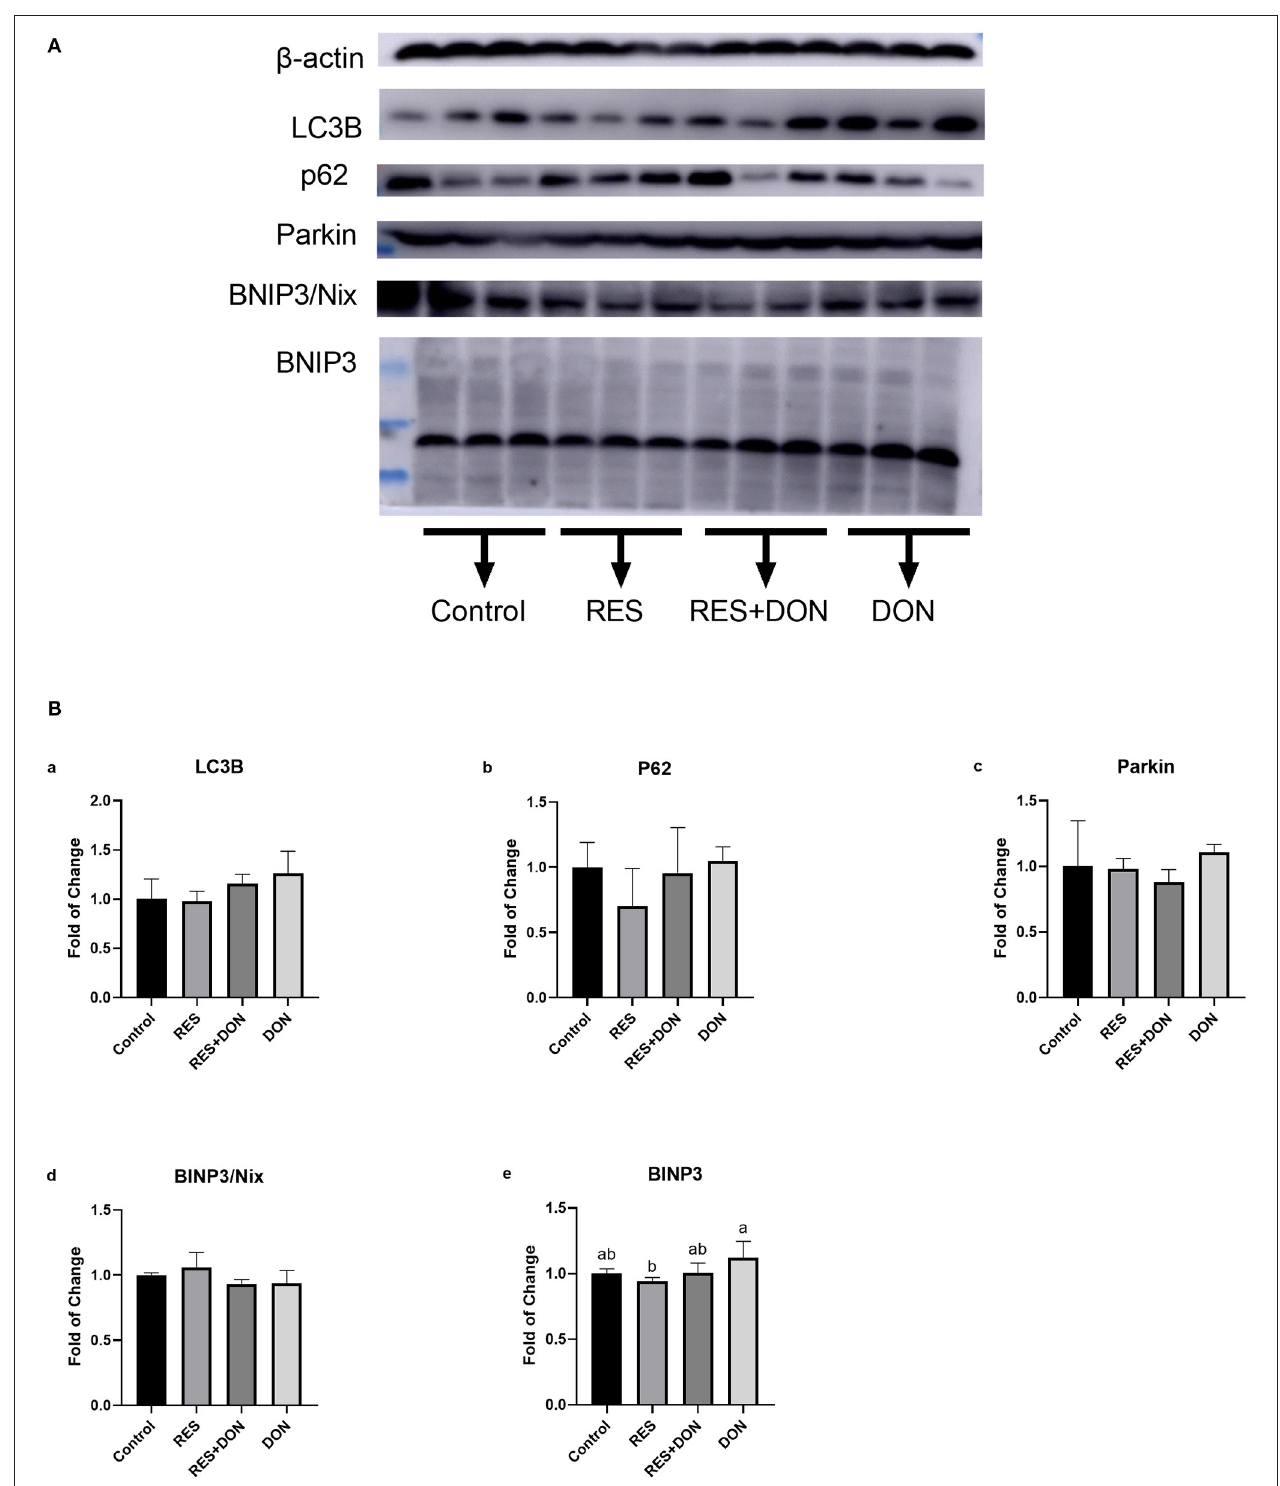
FIGURE 2 | Dietary supplementation with RES increases the expression of mitophagy-related genes. Cells were treated with 0 (NC) or 0.5 µ mol/L DON and 0 or 15 µ M RES, respectively. Data were expressed as means ± SEM of at least three independent experiments. (A,B) Values with different letters are significantly different ( P <